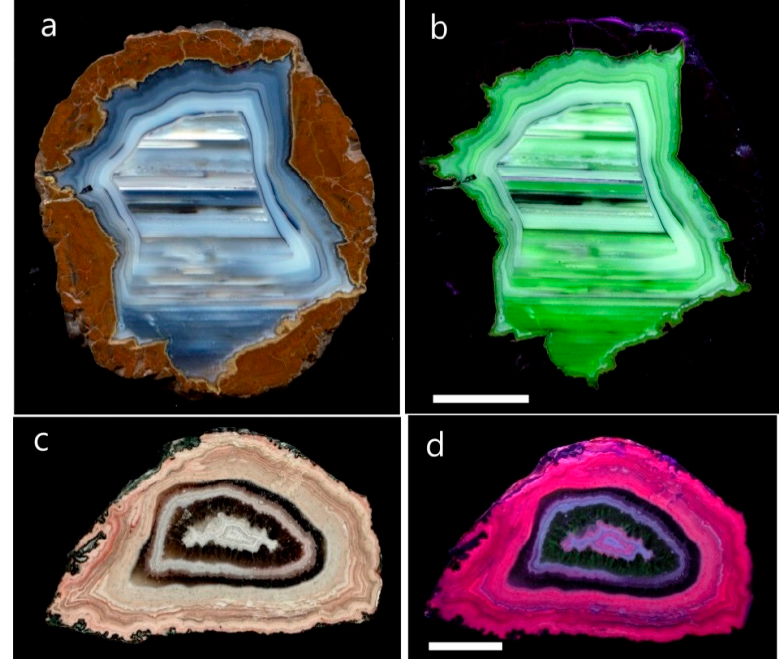
Figure 13. Agates from the Richardson Ranch, Oregon (USA, ( a , b )) and from Idar ‐ Oberstein (Germany, ( c , d )) in day light (left) and under short ‐ wave UV excitation (Photoluminescence, right); scale bar is 2 cm; the green luminescence is caused by uranyl ions (UO 22+ ), whereas the dominant reddish PL can be related to structural defects in the SiO 4 ‐ network.